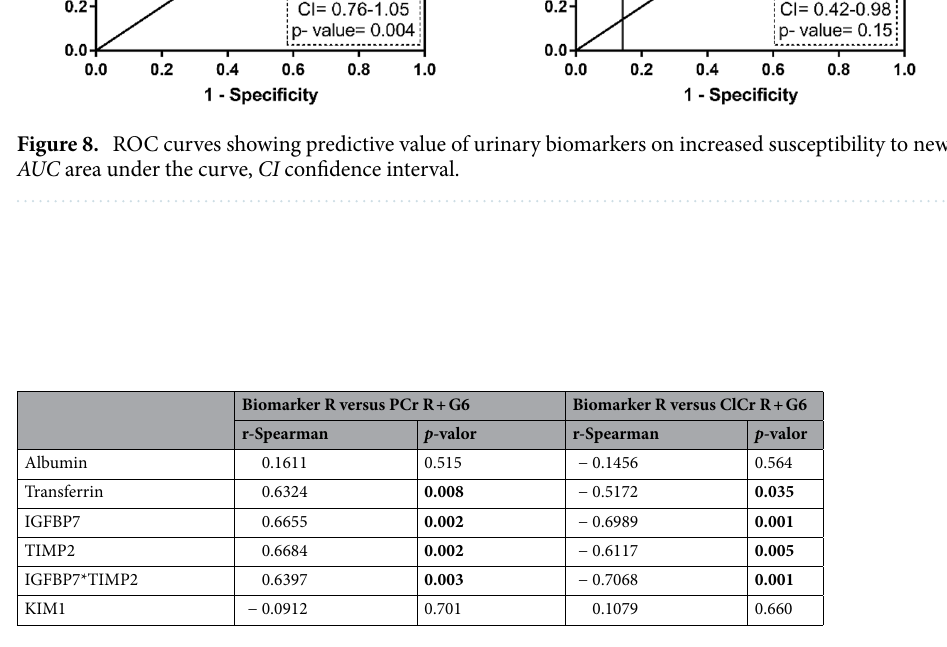
Table 1. Correlation of urinary biomarker levels at the predisposition stage with the severity of the subsequent AKI. Spearman’s correlations between urinary levels of biomarkers in recuperation points (R0, R1, R2) with the increase in plasma creatinine and the decrease in creatinine clearance determined after 6 days of subtoxic gentamicin treatment (50 mg kg −1 body weight) (R0 + G6, R1 + G6, R2 + G6) started at every recuperation point. In bold, statistically significant